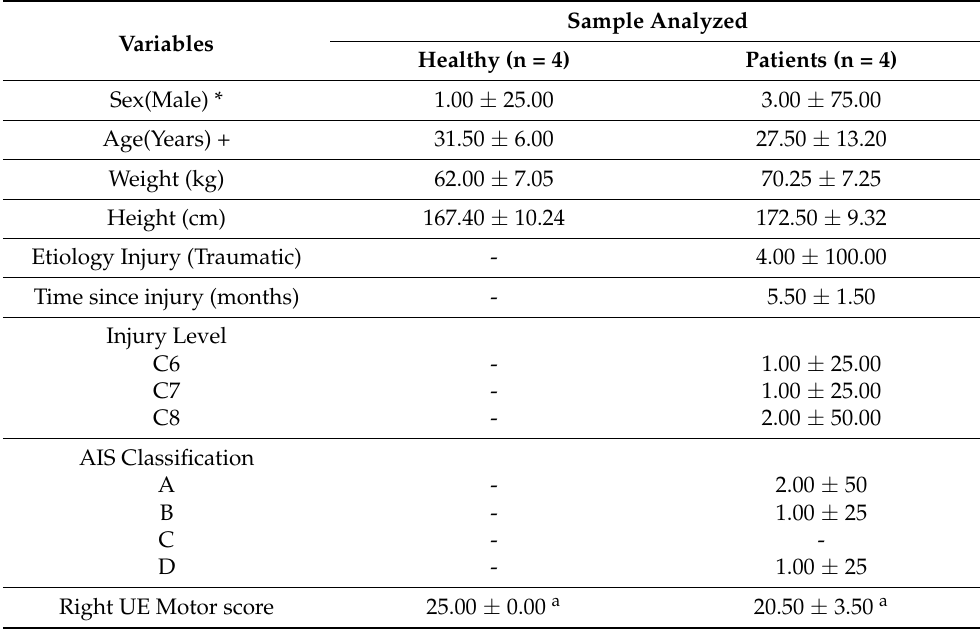
Table 1. Demographics and functional characteristics of the sample